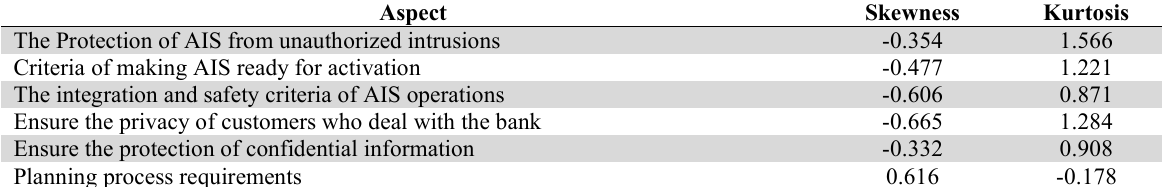
Normal distribution data test (Skewness & Kurtosis)